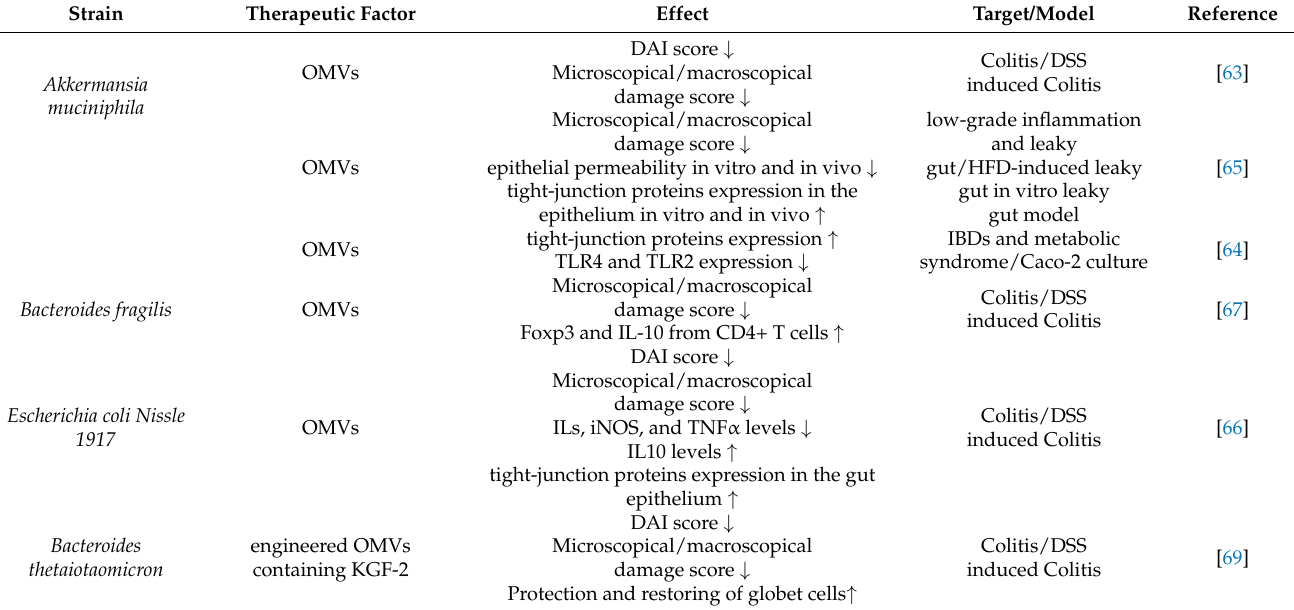
Table 2. Table summarizing the main OMV applications in